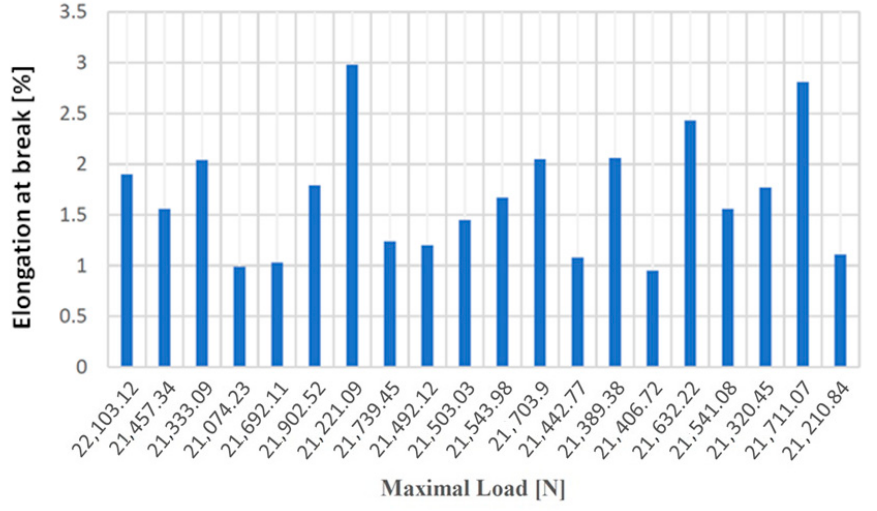
Figure 10. Elongation at break values at failure depending on the maximum forces applied to the 20 samples made of cast iron with lamellar graphite type EN-GJL-250.